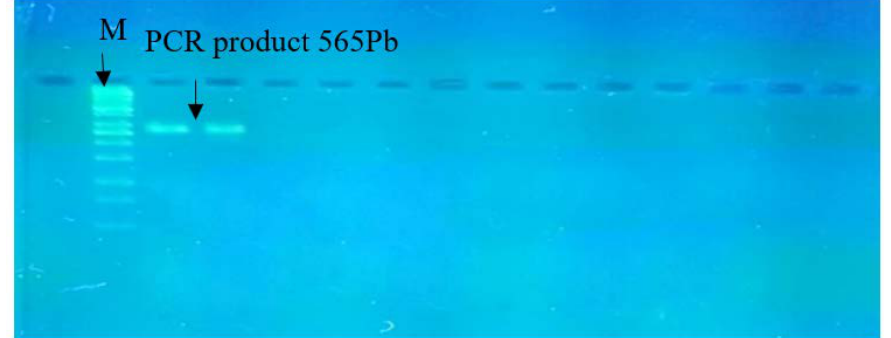
Fig. 2. PCR product, the band size of 565 bp. The product was electrophoresis on 1.5% agarose at 5 volt/cm 2 . Also, 1x TBE buffer for 1.5 h, DNA ladder (100), lane (1 to 2) PCR product of band size 565 bp, visualized under UV